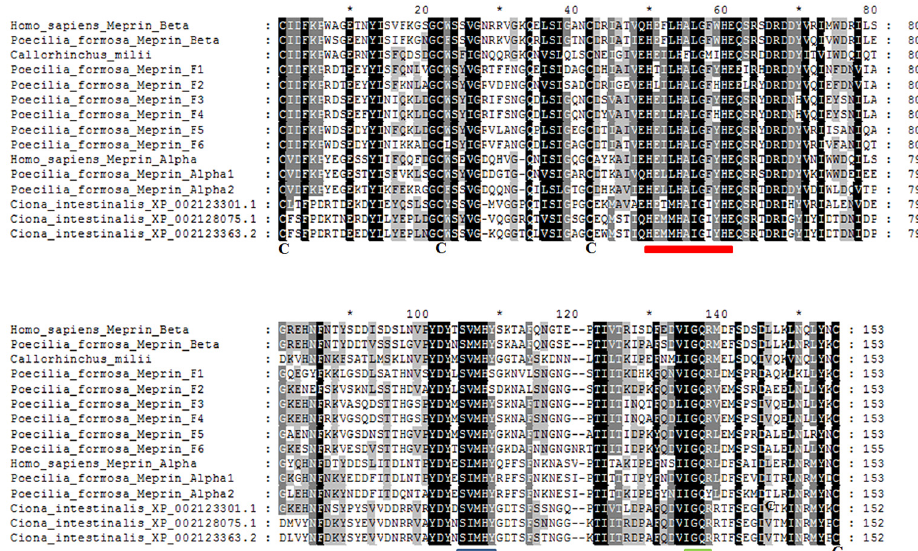
Fig 9. Protease domains of selected meprins. Critical cysteine residues are highlighted. Red: zinc-binding motif. Blue: Met-turn. Green: S1 ’ subsite [see 15 for details]. Sequences ordered as in Fig 8. Accession numbers as follows: H . sapiens Meprin β : NP_005916.2; P . formosa Meprin β : XP_007548801.1; Callorhinchus milii : XP_007910219.1; P . formosa Meprin F1: XP_007553841.1; P . formosa Meprin